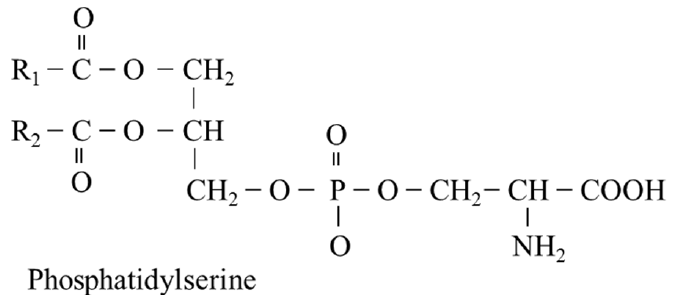
Figure 8. Chemical structure of phosphatidylserine. The fatty acid at position 1 is saturated (R1), the fatty acid at position 2 is unsaturated (R2).